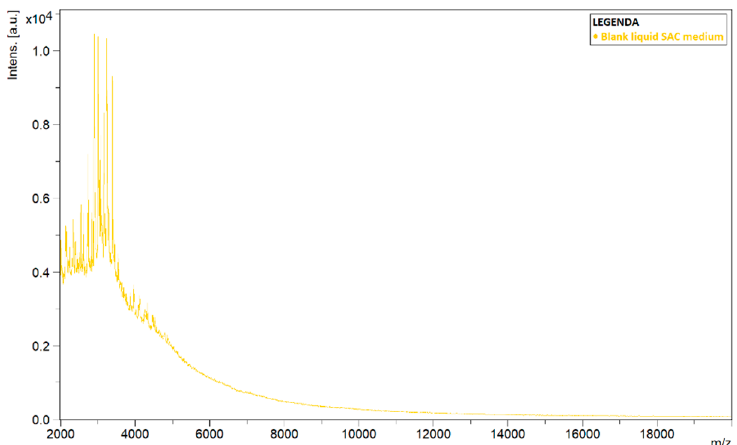
Figure 3. Detected spectrum of a blank sample of liquid Sabouraud–chloramphenicol medium amended with actidione (SAC). Spectrum shows the signal intensity (Intens., in absorption units) of the ions detected by MALDI-TOF MS, as a function of their mass-to-charge ratio ( m / z , in kg/C).